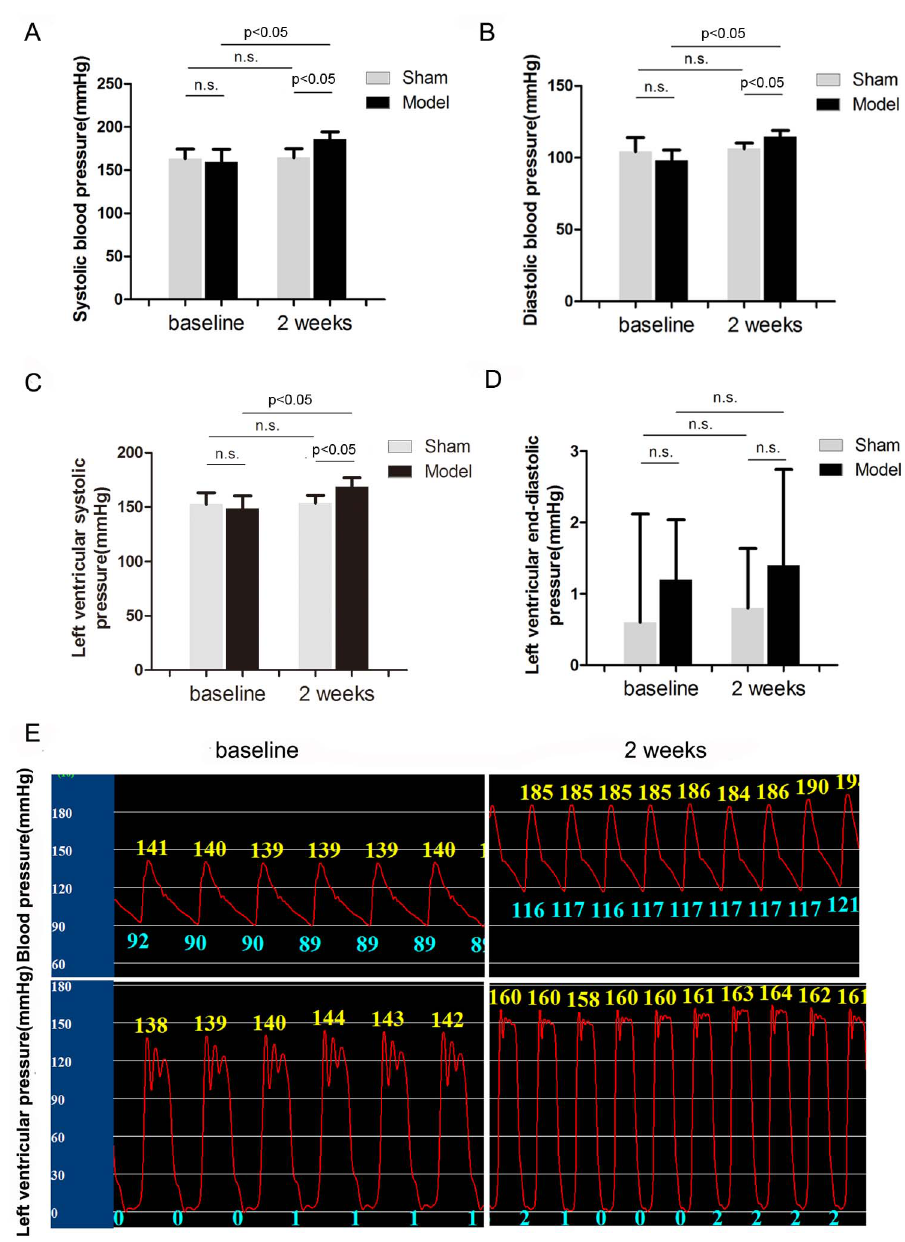
Figure 3. Analysis of BP and LV pressure (n=5). Effects of embolization versus sham operation on SBP (A), DPB (B), LVSP (C) and LVEDP (D). Representative BP wave (upper) and LV pressure wave (lower) of dogs at baseline and with RI after 2 weeks of embolization in the model group